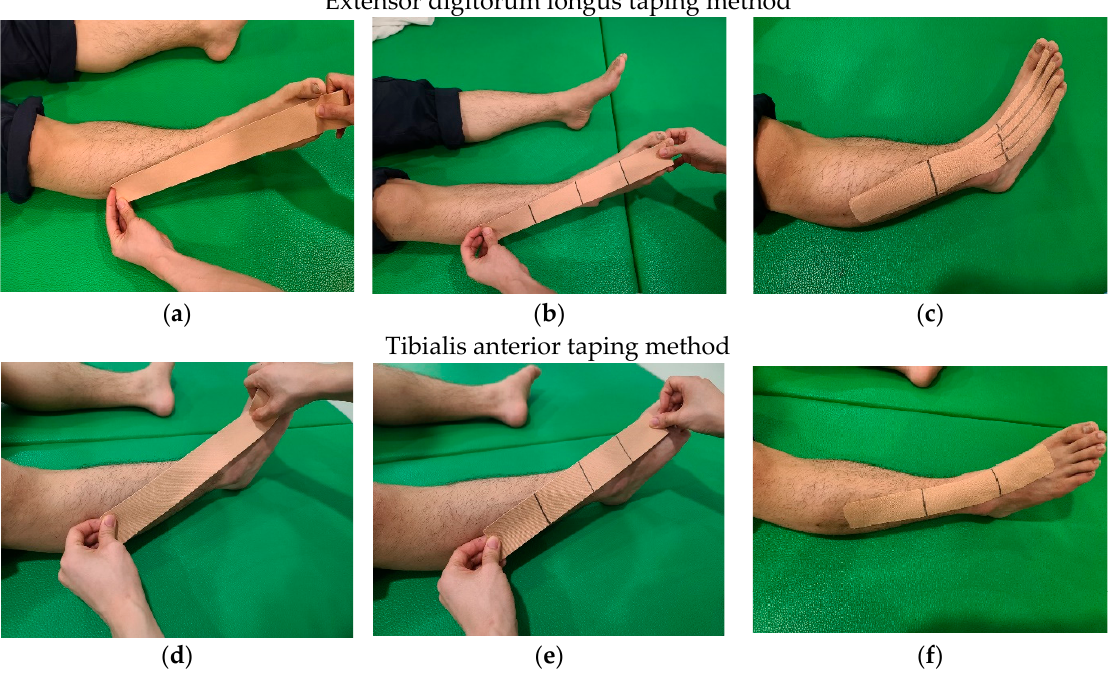
Figure 1. Diagram of taping method is as follows: ( a ) Measure muscle length with tape; ( b ) divide the length of the tape into 4 equal parts; ( c ) attach to muscle while stretching tape with 1/4 length removed; ( d ) Measure muscle length with tape; ( e ) divide the length of the tape into 4 equal parts; ( f ) attach to muscle while stretching tape with 1/4 length removed.